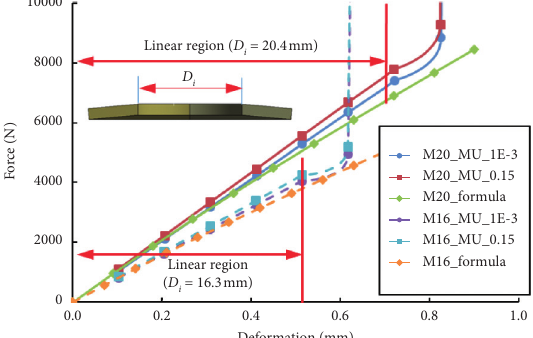
Figure 20: A comparative study of the force-deformation rela- tionship of disk springs: FE simulation and the formula of DIN2093.